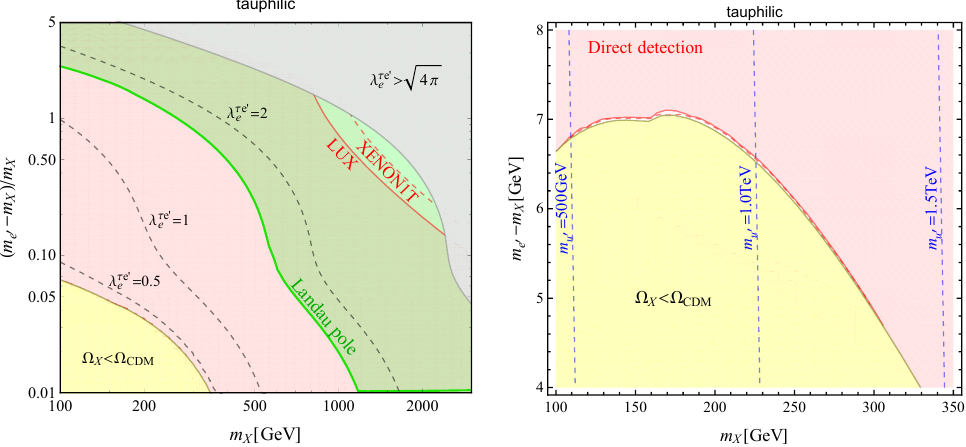
Figure 5 . m vs. the mass di(cid:11)erence between e X charm and top-philic cases, we show various contours and the relevant constraints. In the right panel, blue dashed lines show contours for mirror up-quark